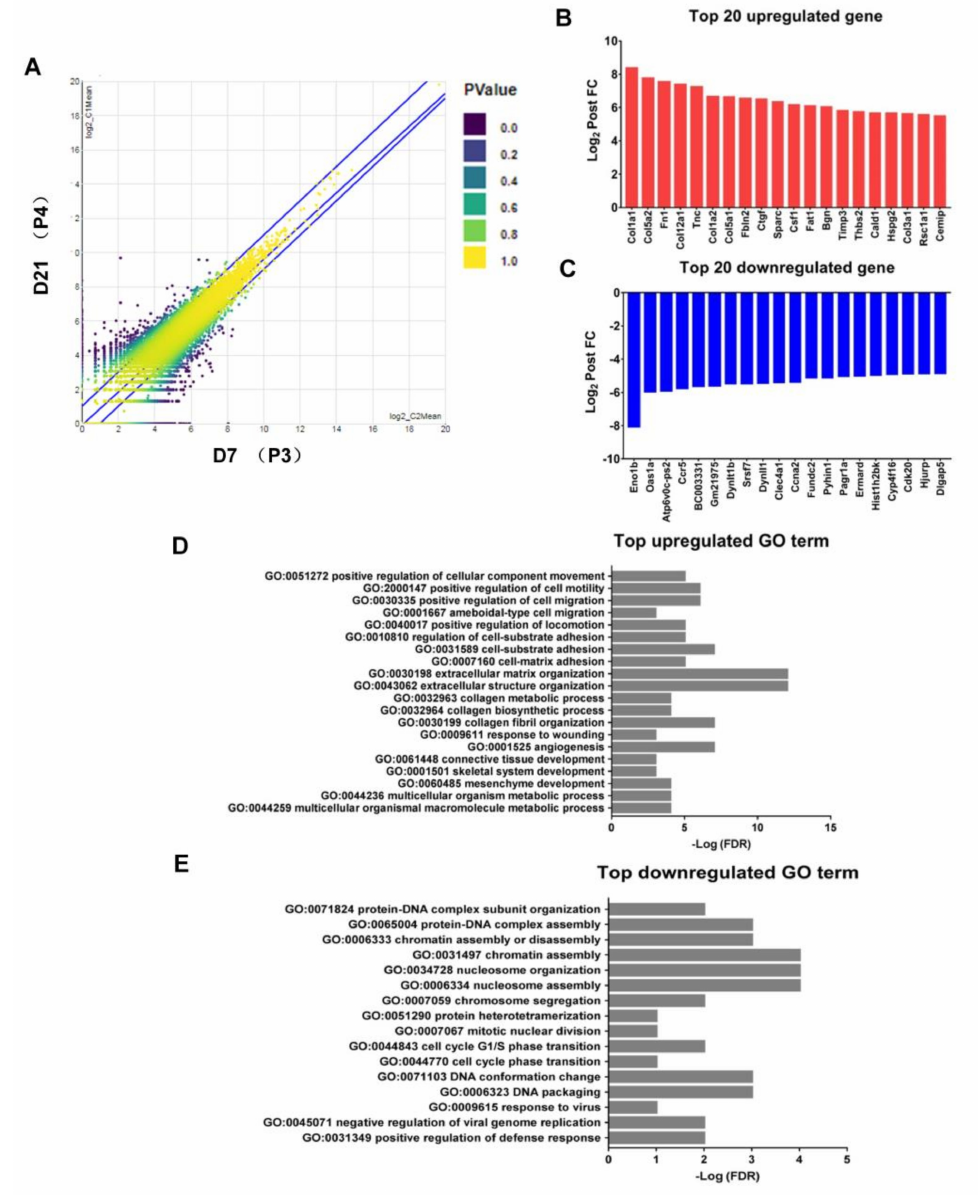
Figure 5. Transcriptome analysis of Top 20 differentially expressed genes in P4 vs. P3 M2 macrophages. ( A ) The scatter plot revealed 272 differentially expressed genes (DEGs) in macrophages on day 21 (P4) compared with that on day 7 (P3). ( B , C ) Histograms of the top 20 upregulated genes (red) and downregulated genes (blue). ( D ) Bar plot of the top upregulated biological process gene ontology (GO) analysis in P4 compared with P3. ( E ) Bar plot of the top downregulated biological process GO analysis in P4 compared with P3 (FDR ≤ 0.05), n =